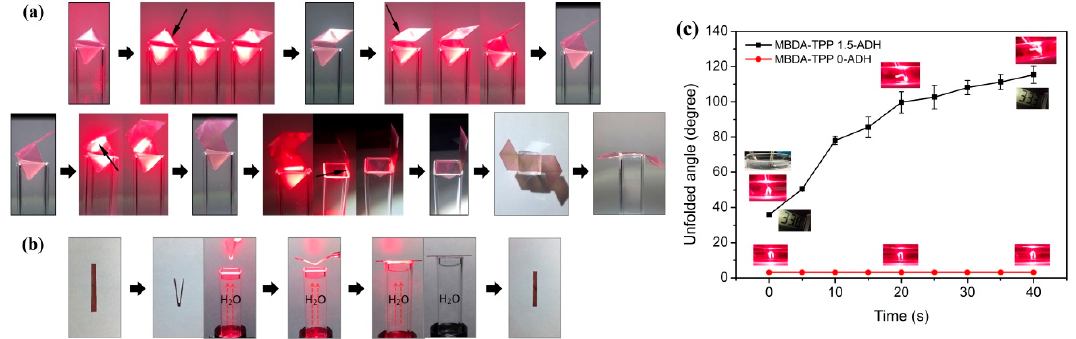
Figure 7. Light-controlled spatially-selective shape recovery process. ( a ) Reverting from the temporary shape of octahedron to the permanent shape of the plane; ( b ) shape recovery occurred under the light passing through the water column; ( c ) the plot of unfolded angle vs. exposure time of films submerged in water.